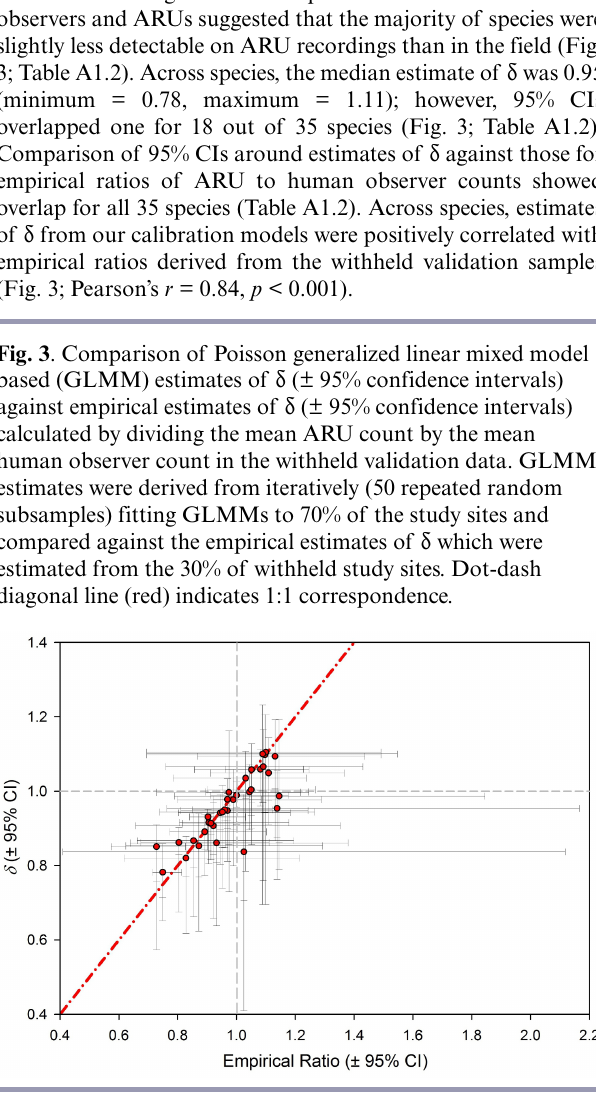
Applying δ estimates within the statistical offsets resulted in reduced bias for 33 out of 35 species compared to modeling the data using offsets taken solely from human observer data (Fig. resulted in 24 species with negative biases in their density estimates (Fig. 4). Of the 24 species with negatively biased density estimates derived using uncorrected offsets (taken from human observer data), five species (Ovenbird [ Seiurus aurocapilla ], Dark-eyed Junco [ Junco hyemalis ], Ruby-crowned Kinglet [ Regulus calendula ], Clay-colored Sparrow [ Spizella pallida ], and Connecticut Warbler [ Oporornis agilis ]) had 95% CIs that did not overlap zero (Fig. 4), whereas density estimates for these same species were unbiased when δ was incorporated in the offsets (Fig. 4). For Ovenbird, failing to incorporate δ within the offset resulted in density being underestimated by 0.10 birds ha -1 on average.